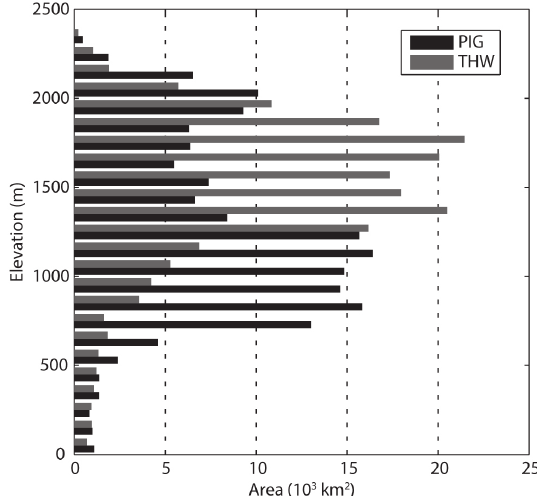
Figure 2. The hypsometric distributions of the Pine Island and Thwaites glacier catchments. The sub-basins included in PIG are Pine Island glacier and the Wedge and in THW the Thwaites, Thwaites East, and Haynes glaciers. The median elevations within the PIG and THW are 1210 and 1540ma.s.l.,